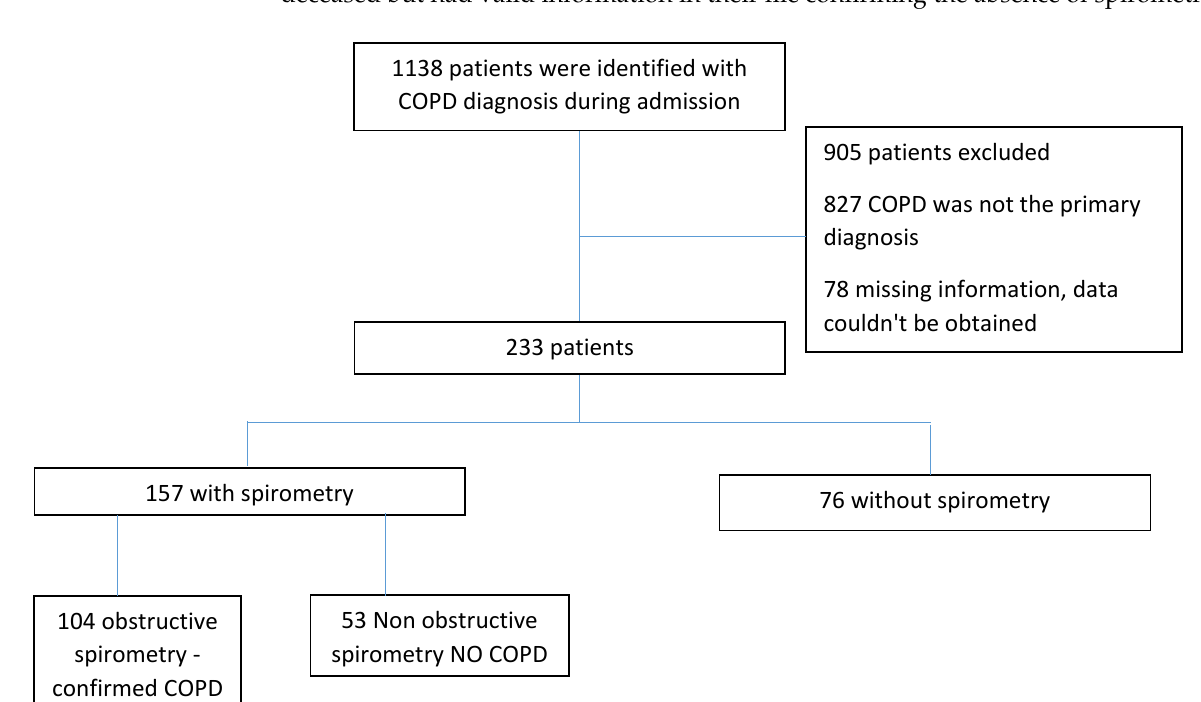
Figure 1. Flowchart showing the distribution of participants and their classification in the different groups and